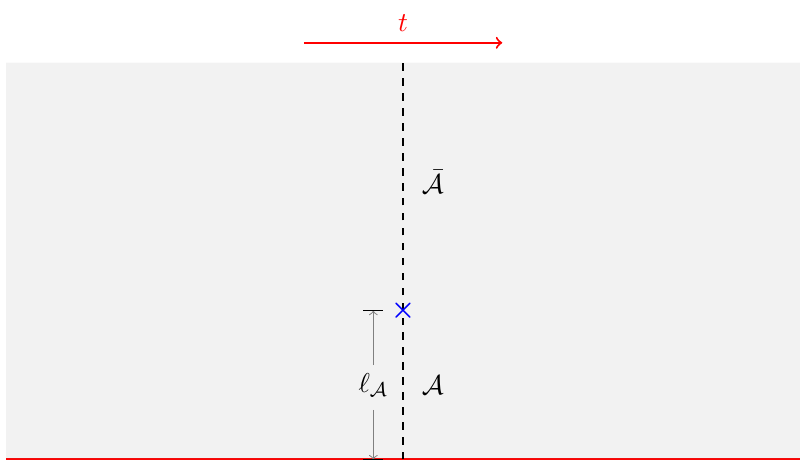
Figure 2 . We consider a two dimensional boundary conformal field theory living on the upper half plane (UHP). The bulk CFT is in the vacuum state, the boundary is specified by the horizontal axis (in red) and the time direction is along the horizontal direction. We consider a constant time slice (dashed black vertical line) which defines the state we are looking at. For this state, we want to compute the entanglement entropy of the region A (between the blue cross and the boundary) with its complement ¯ A